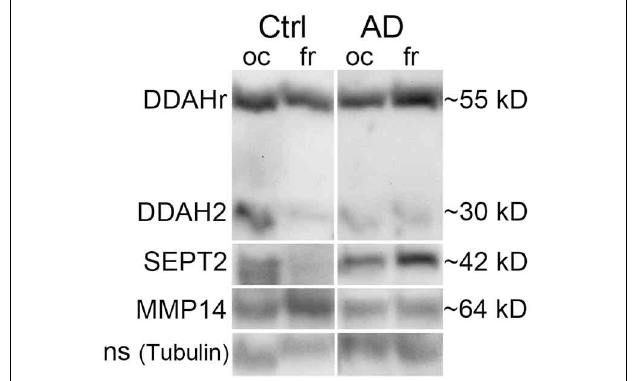
FIGURE 5 | Western immunoblot example set of AD and control brain post-mortem samples. DDAH, SEPT2, and MMP14 were examined from the age matched samples. The shown sample sets are from one control and one AD subjects, the shown bands being detected from the same membrane after stripping. DDAH2 reduced in oc lobe of AD patients but increased in fr lobe, similarly as the around 40kD form. The around 55kD form is possibly complexed DDAH2 (29kD) or DDAH1 (the size of a biological form of DDAH1 is 37kD), as shown in 2D-gel ( Figure 1 , spot 6). SEPT2 increased and MMP14 reduced in fr lobe in AD. With tubulin antibody detected non-specific (ns) band was a loading control due to excess intensity of tubulin. Ctrl, control; AD, Alzheimer’s disease; oc, occipital lobe sample, fr, frontal lobe